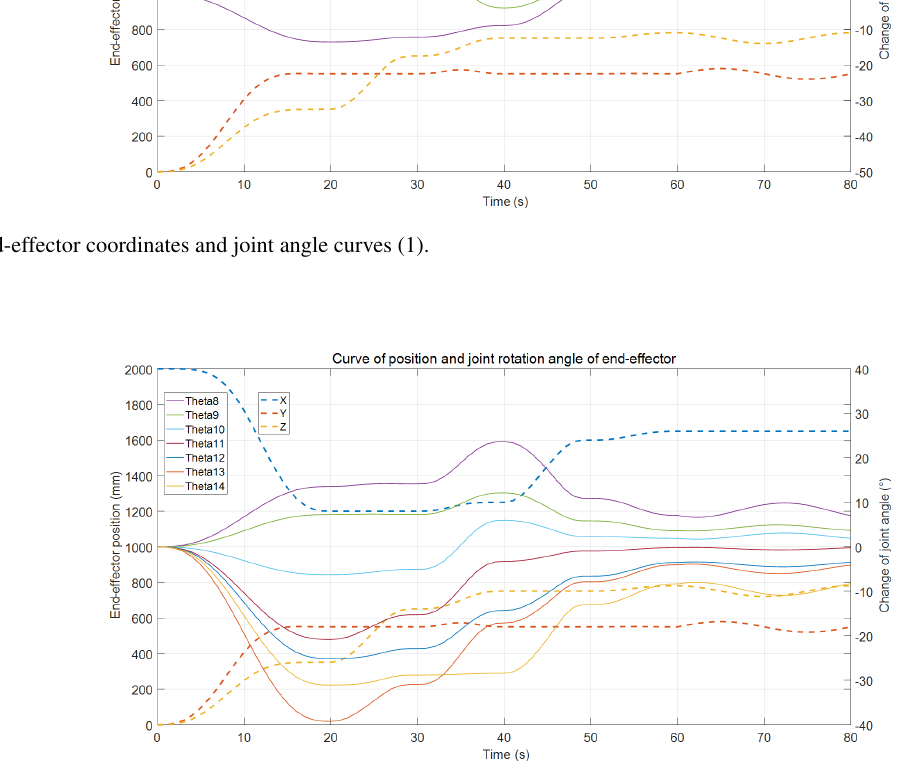
Figure 7. End-effector coordinates and joint angle curves (2).